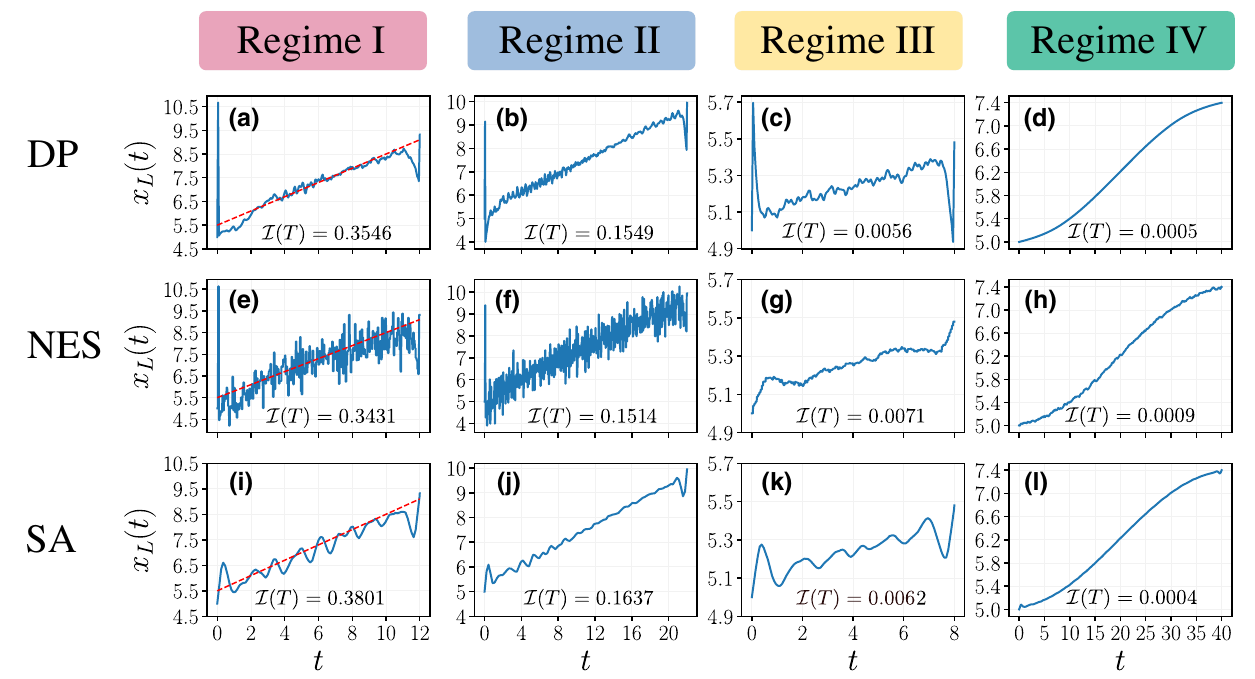
FIG. 2. Overview of the optimal controls in the four different Majorana motion regimes [(I)–(IV)] obtained after optimization with DP, NES, and simulated annealing (SA). In all panels we plot the domain-wall position x L ( t ) as a function of time starting from x L ( 0 ) = x A = 5.0. The red dotted line in regime (I) has a slope equal to the critical velocity. Regimes (I)–(III) show a pulselike motion at the edges and an on average constant velocity in the bulk of the protocol. In regime (IV) the strategy is to slowly build up to constant speed and then slow down again. In these simulations we set N = 110, μ = 1, w = 1, (cid:3) = 0.3, V height = 30.1, and σ = 1. The constraint parameters ( l , T ) are given by { ( 4.32, 12 ) , ( 4.95, 22 ) , ( 0.48, 8 ) , ( 2.4, 40 ) } for regimes (I), (II), (III), and (IV),